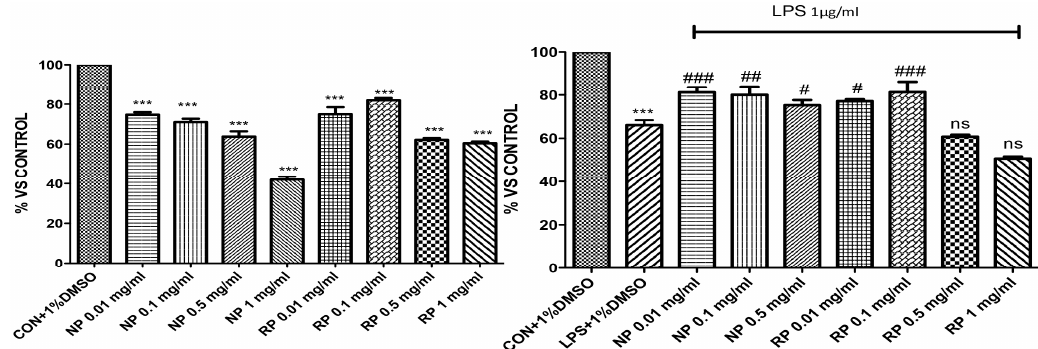
Figure 1. Effect of the pistachios on cell viability. Cell viability was assessed 24 h after treatment with the indicated concentrations (1.0 mg/mL, 0.5 mg/mL, 0.1 mg/mL, and 0.01 mg/mL) of NP and RP, respectively; cell viability was significantly reduced with NP at the highest concentration of 1 mg/mL. NP and RP at 0.5, 0.1, and 0.01 mg/mL lacked cytotoxicity. Moreover, incubation of cells with LPS significantly reduced cell viability compared to the control group, whereas pretreatment with NP at the concentrations of 0.01, 0.1 and 0.5 mg/mL and RP at the concentrations of 0.0 and 0.1 mg/mL significantly limited reduction of cell viability. Data are representative of at least three independent experiments; *** p < 0.001 vs. Ctr; ### p < 0.001 vs. LPS; ## p < 0.01 vs. LPS; # p < 0.05 vs. LPS.